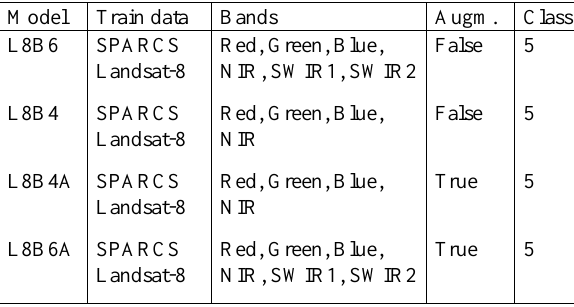
Table 1. Training setups for U-Net and Random Forest